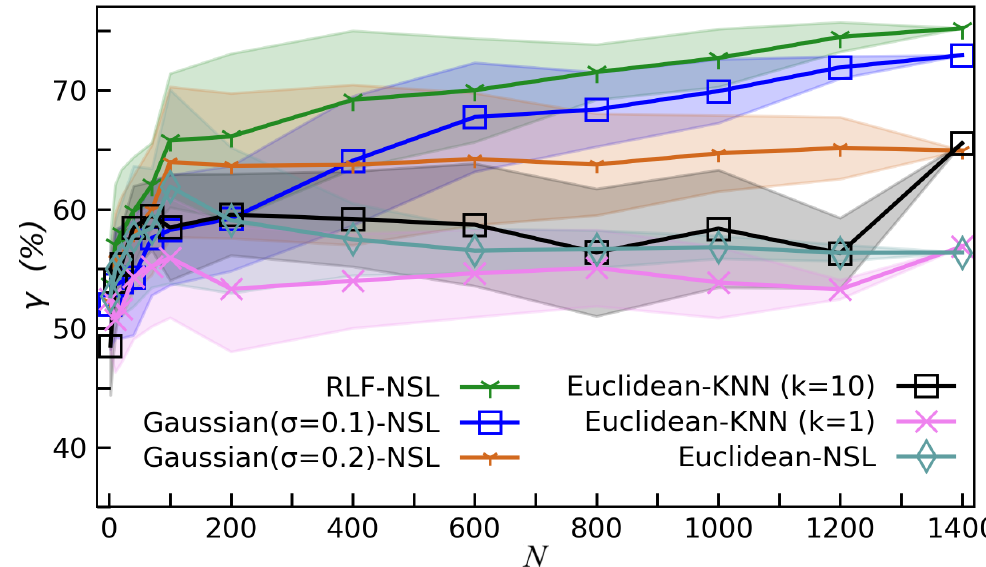
Figure 4. The testing accuracy of the RLF-NSL on the IMDb dataset comparing different kernels (Euclidean, Gaussian, and RLF) and classification strategies (KNN and NSL). The x-axis shows the number of labeled samples in each class. For more results of the KNN with different values of k and those of the Gaussian kernel with different values of σ , please refer to the Appendix